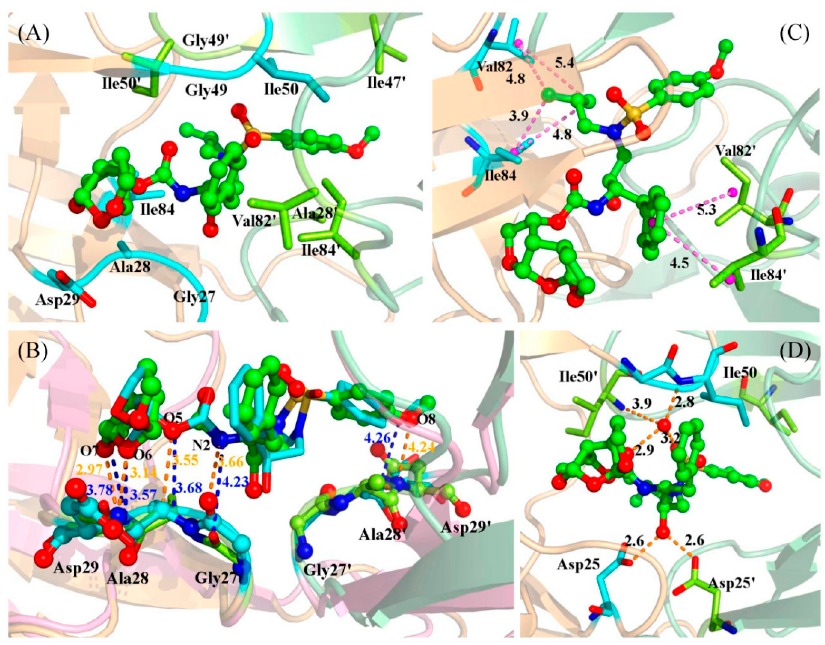
Figure 5. ( A ) Key residues interacted with the inhibitor in the WT; ( B ) Key residues of D30N superimposed on those of the WT. The averaged distances are shown with dashed lines in blue (D30N) and orange (WT). The D30N is shown in pink; ( C ) The van der Waals interactions between the inhibitor and residues in the WT. The averaged distances are shown with a dashed line; ( D ) The averaged distances between a bridge water molecule and Ile50/Ile50 ′ /inhibitor, and the distances between the inhibitor and Asp25/Asp25 1 . Protein is shown in cartoon representation. Chain A is shown in light orange, and chain B in pale green. Key residues are shown in stick representation and labeled with residue names. The inhibitors are shown in stick and ball representation. The key distances are also